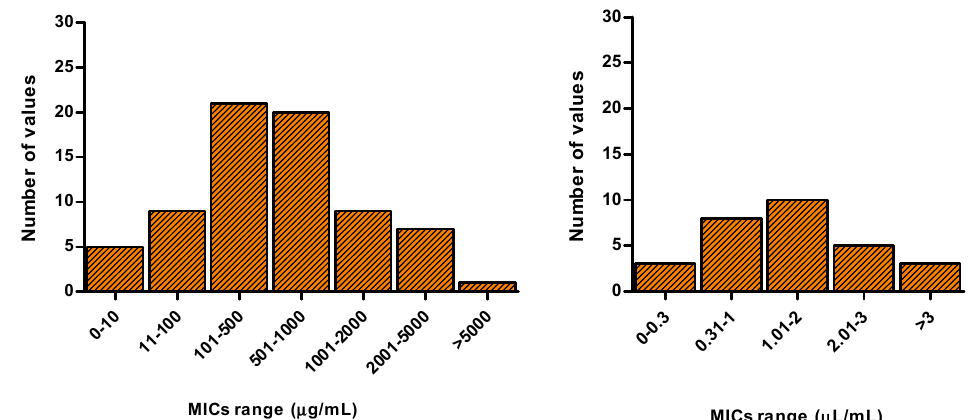
Figure 2. Frequency of distribution of Minimum Inhibitory Concentration (MIC) values related to the selected EOs. Studies reporting MICs obtained from plant species analyzed in different seasons or collected in different regions were excluded from the analysis. Table 2. Minimum Inhibitory Concentrations (MICs) of the EOs with anti- Candida activity. Species Plant part